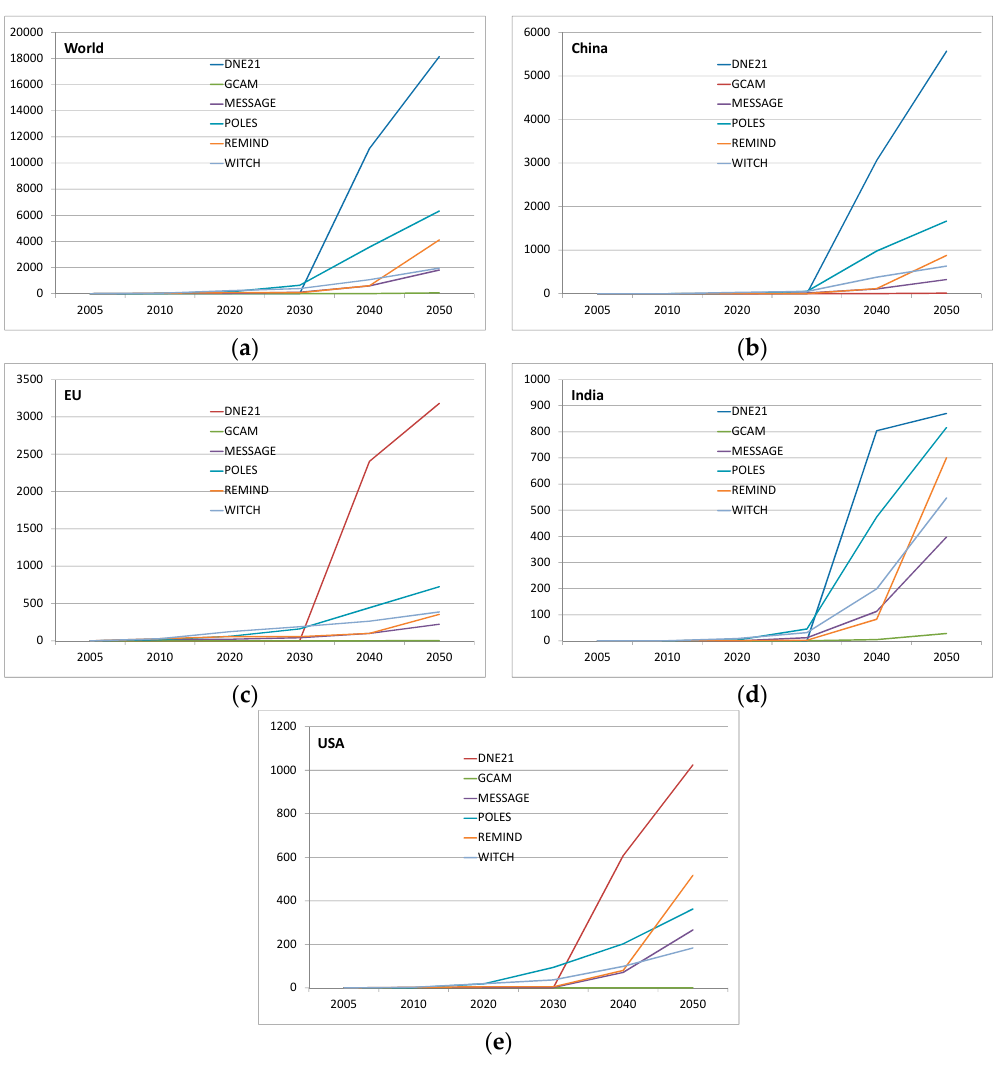
Figure B2. Inter-model comparison of installed capacity (GW) for solar PV in ( a ) World (2030–2050 growth rate = 8%–22% p.a.); ( b ) China (2030–2050 growth rate = 13%–35% p.a.); ( c ) The EU (2030–2050 growth rate = 4%–10% p.a.); ( d ) India (2030–2050 growth rate = 15%–22% p.a.) and ( e ) USA (2030–2050 growth rate = 3%–30% p.a.) Energies 2017 , 10 , x